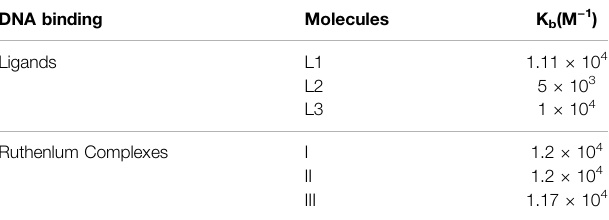
TABLE 5 | DNA binding constant (K b ) values for TSC ligands and Ru complexes. DNA